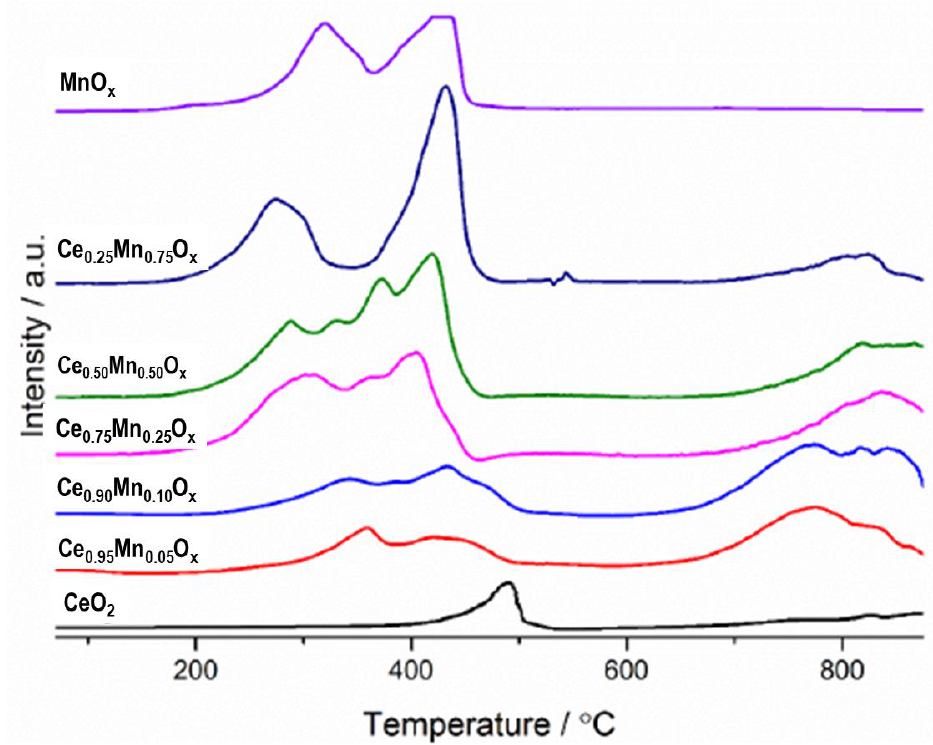
Figure 4. H 2 temperature programmed reduction (TPR) profiles of ceria-manganese catalysts synthesised by co-precipitation using sodium carbonate. Reaction conditions: 30 mL min −1 10% H 2 /Ar, Temperature range = 50 –850 °C.